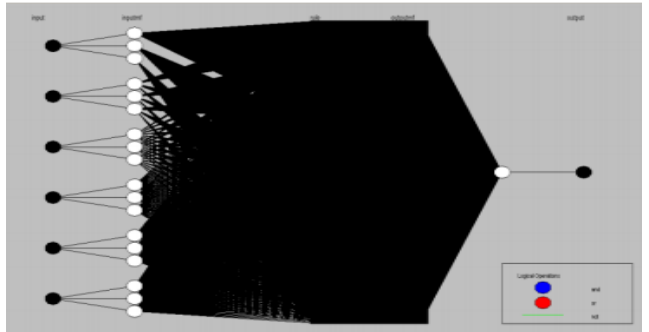
Figure 17. Correlation of inputs with the